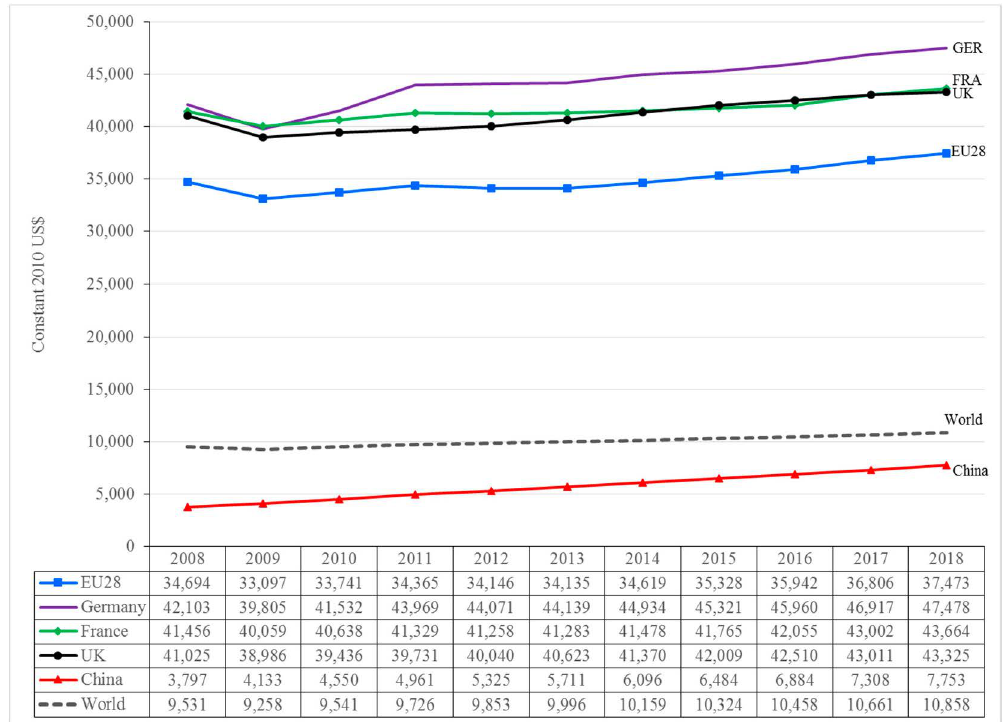
GDP per capita (constant 2010 US$), 2008–18. Source: The World Bank, ‘DataBank’ (2020) <http://databank.worldbank.org/data/home.aspx> accessed 27 February